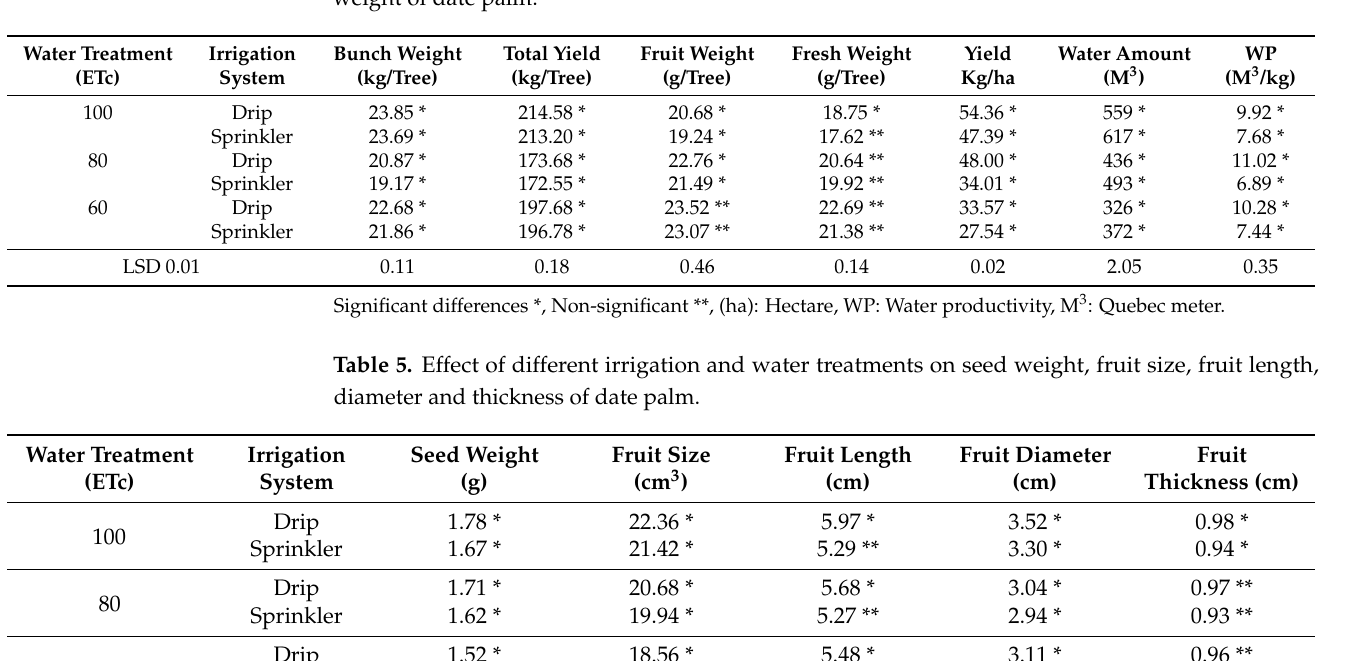
Table 4. Effect of different irrigation and water treatments on bunch weight, total yield fruit and flesh weight of date palm.